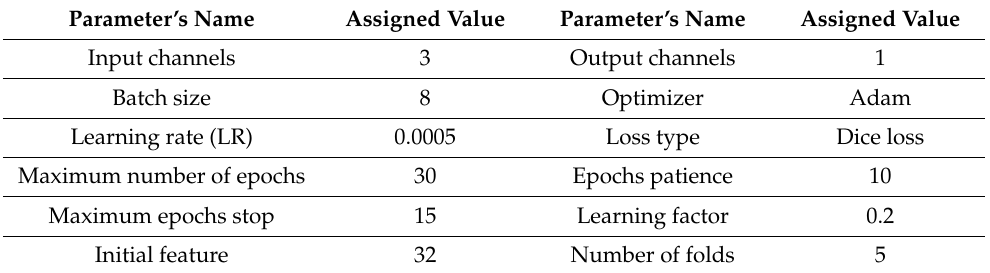
Table 4. Hyper-parameters for all segmentation models.